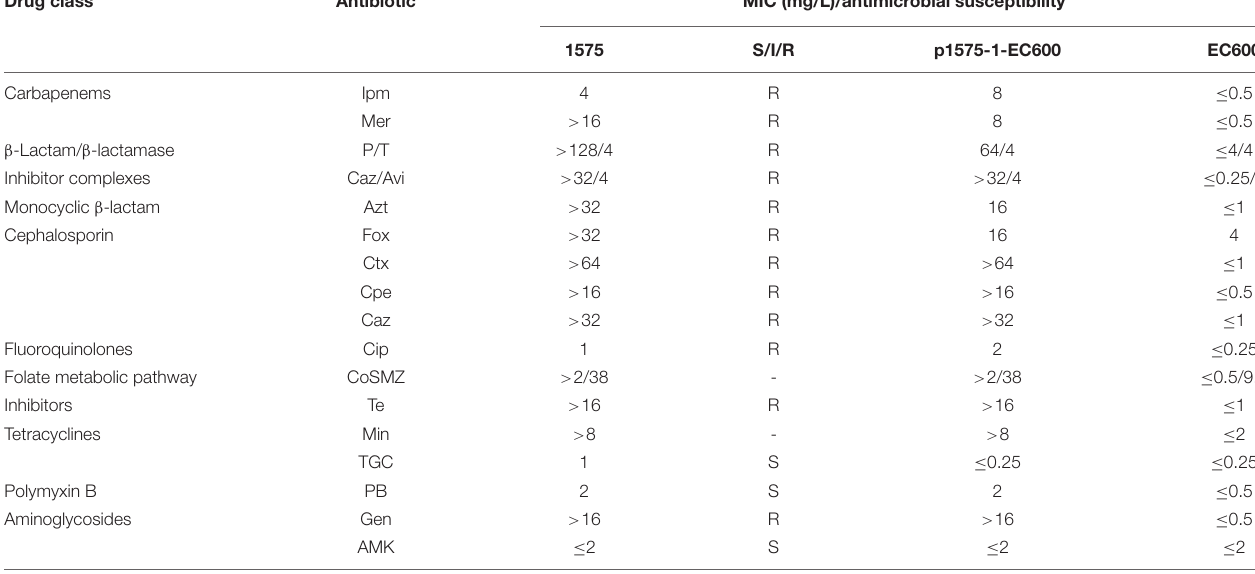
TABLE 2 | Antimicrobial drug susceptibility profiles.